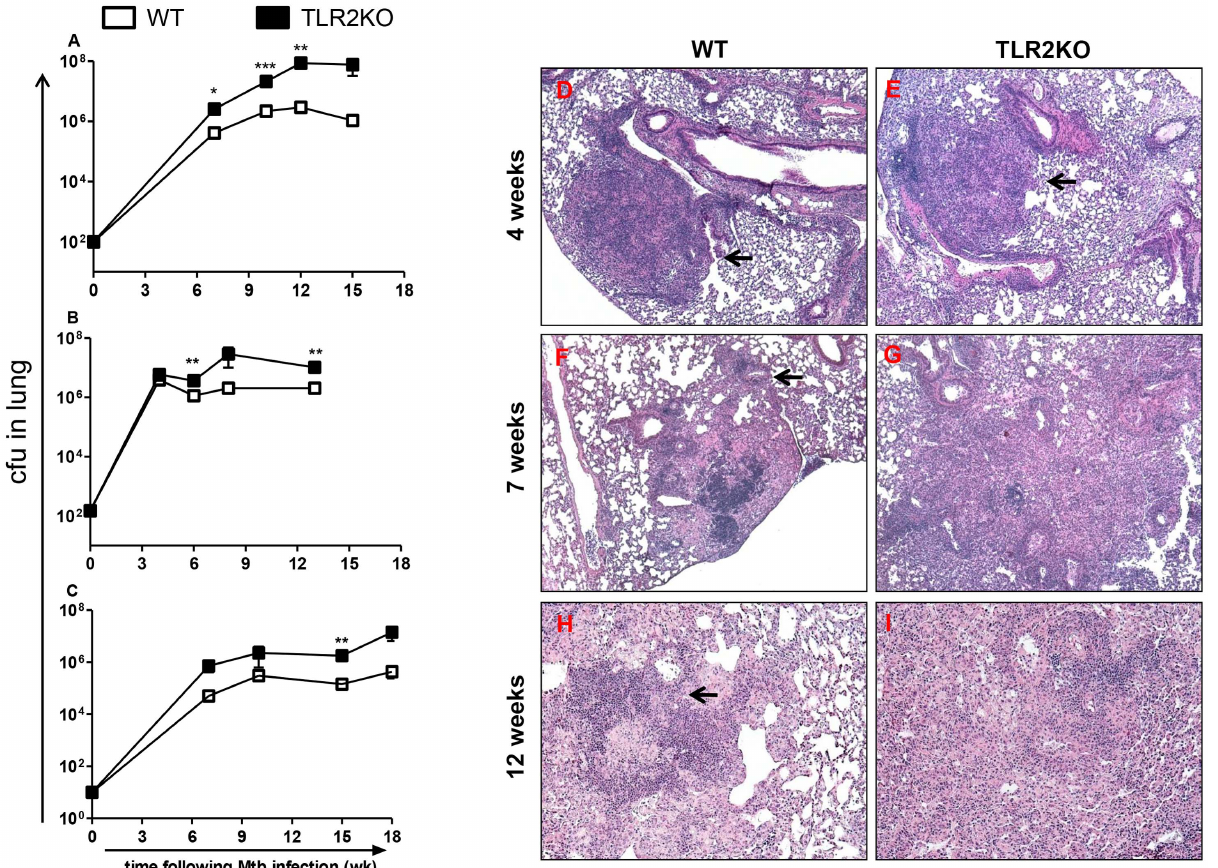
Figure 1. Loss of control of bacterial burden and disrupted granuloma morphology in the absence of TLR2 during chronic stages of Mtb infection. Bacterial burden in the lungs following aerosol infection with Mtb at doses of 100 CFU (A), 150 CFU (B), or 10 CFU (C) was compared between WT and TLR2KO mice. The numbers of viable bacilli were determined by plating serial dilutions of lung homogenates onto 7H11 agar plates. CFU were counted after 21 days of incubation at 37 u C. Each time point includes 4–5 mice per group, except for the 15 week time point in (A), which includes 2 mice per group, and the 18 week time point in (C), which includes 4 WT and 3 KO mice. Panel (A) is representative for 1 of 3 independent experiments. Data are presented as mean CFU counts 6 SEM. Asterisks represent statistically significant differences between WT and KO at a particular time point. *=p , 0.05, **=p , 0.01, ***=p , 0.001. Formalin-fixed, paraffin-embedded lung tissue was obtained at 4 weeks (D–E), 7 weeks (F–G), and 12 weeks (H–I) following infection. Sections were stained using a standard H&E protocol. Photomicrographs were taken at 5 6 (D–G) and 10 6 (H–I) magnification. Representatives of sections from 4–5 mice per group are shown.